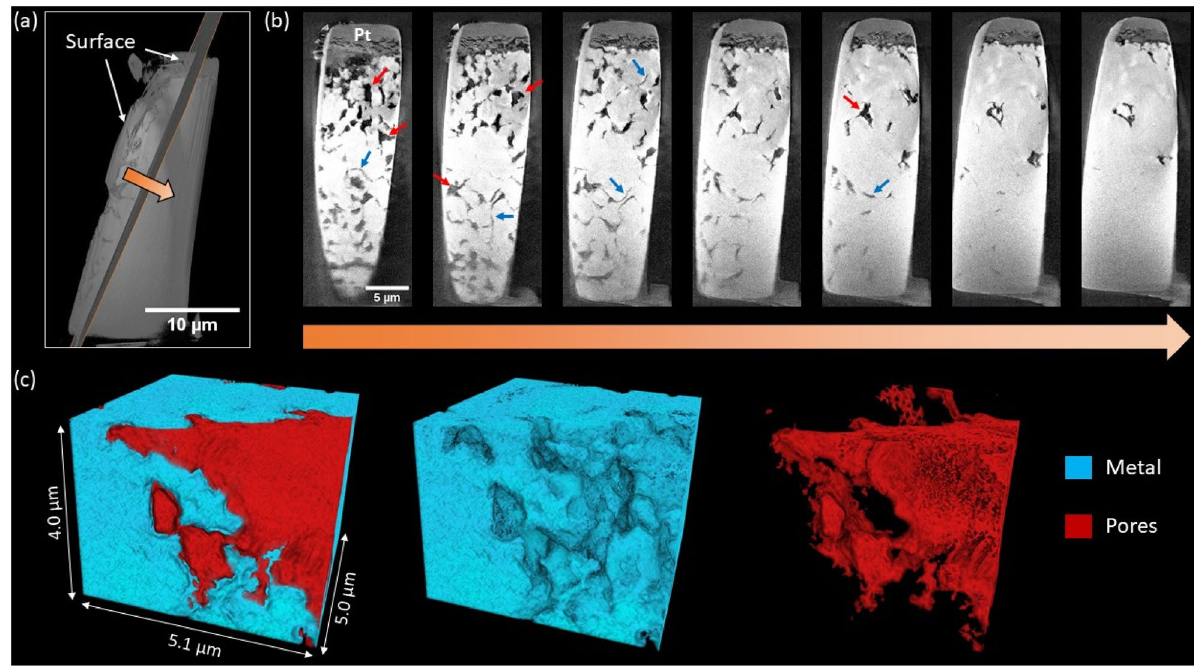
Figure 7. Synchrotron X-ray nano-tomography on Ni–20Cr corrosion in KCl–NaCl in air for 16 h: ( a ) Diagonal slice of interest used for depth profiling. ( b ) Pseudo-2D cross sections along depth direction, spaced approximately 0.4 μm apart. Some larger pores and intergranular cracks are indicated using red and blue arrows, respectively. ( c ) 3D volume rendering of near-surface region displaying pore